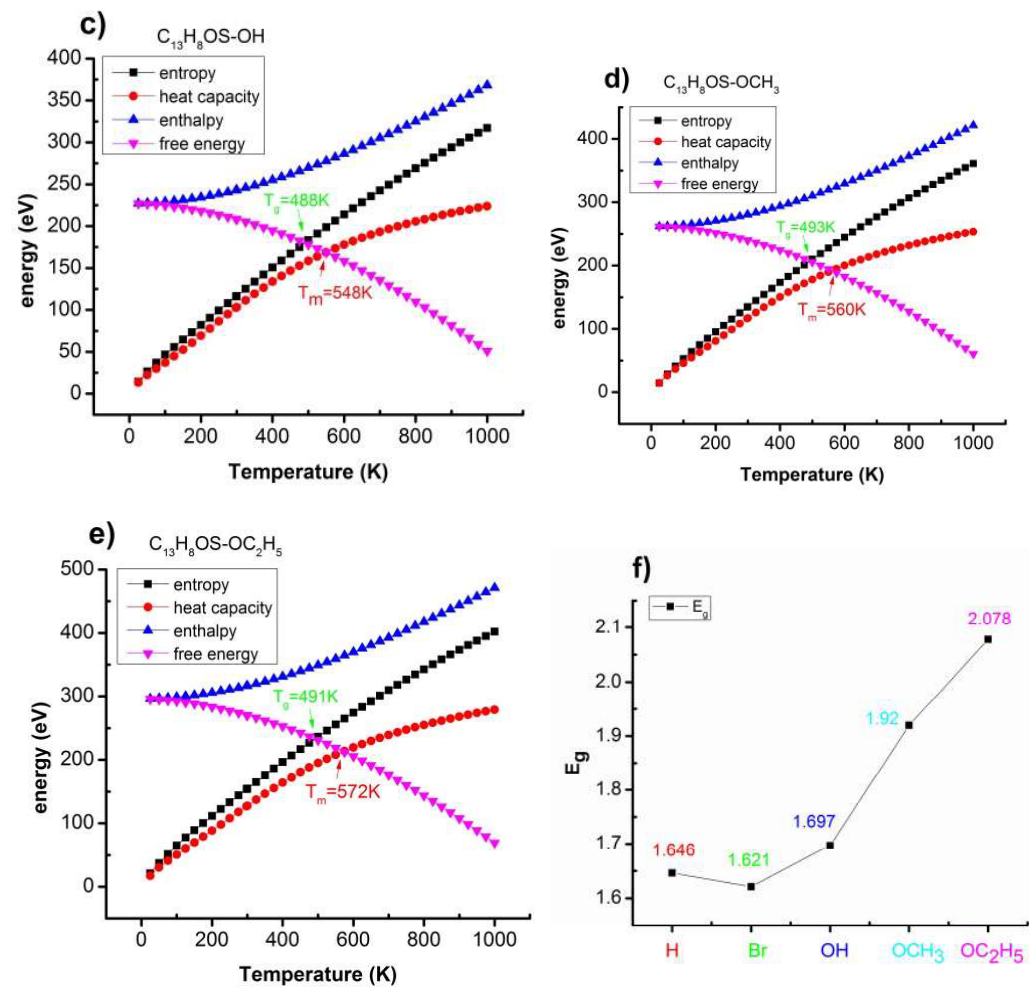
Figure 4. The electronic structures of poly(C 13 H 8 OS–H) ( a ), poly(C 13 H 8 OS–Br) ( b ), poly(C 13 H 8 OS–OH) ( c ), poly(C 13 H 8 OS–OCH 3 ) ( d ), and poly(C 13 H 8 OS–OC 2 H 5 ) ( e ), E g of poly with different impurities ( f ).